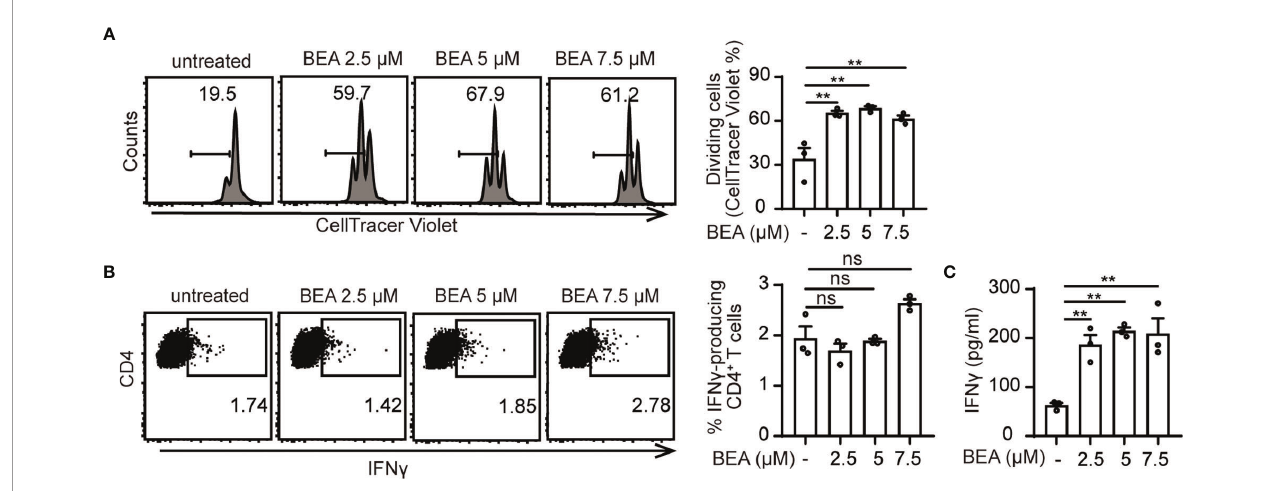
FIGURE 2 | BEA – treated BMDCs enhance T cell proliferation. 10 5 naïve CD4 + T cells derived from OT II TCR transgenic mice were labeled with CellTrace Violet and cultured with 10 4 untreated or BEA-treated BMDCs in the presence of 300nM OVA peptide 323-339 for 3 days. (A) T cell proliferation was analyzed by fl ow cytometry based on CellTracer Violet dilution. Results shown are representative of three independent experiments using cells from 3 mice per group (n=3). (B, C) 10 5 naïve OT II CD4 + T cells were cultured with 10 4 untreated or BEA-treated BMDCs in the presence of 300nM OVA peptide 323-339 for 5 days. (B) Percentage of IFN g production by CD4 + T cells was measured by intracellular staining. Results shown are representative of three independent experiments using cells from 3 mice per group (n=3). (C) IFN g production in the supernatant was detected by ELISA. Results shown are representative of three independent experiments using cells from 3 mice per group (n=3). Data in A, B and C are presented as mean ± SEM and analyzed by one-way ANOVA with Dunnett ’ s multiple comparisons test. **p<0.01, ns, not signi fi cant.